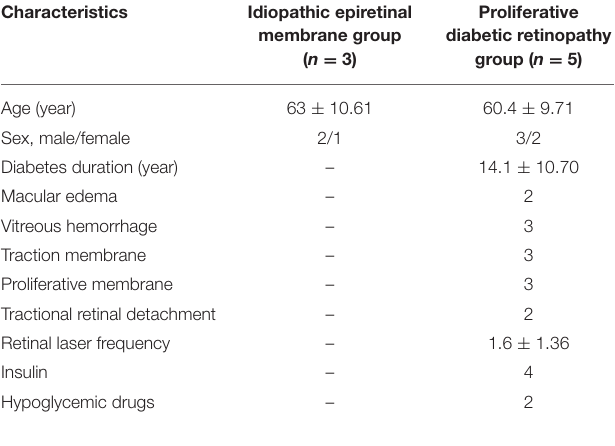
Characteristics